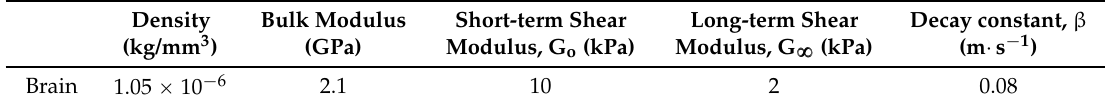
Table 1. Brain viscoelastic material